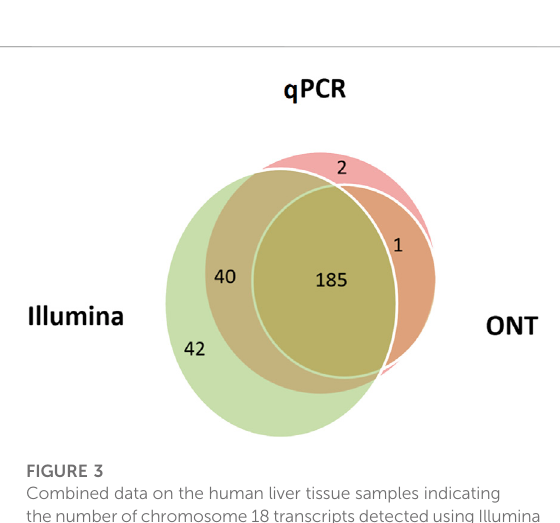
FIGURE 3 Combined data on the human liver tissue samples indicating thenumberofchromosome18transcripts detectedusingIllumina RNA-Seq data (FPKM > 0), qPCR (the number of cDNA copies per cell, S t ≤ 40), and ONT data (TPM > 0). A total of 270 transcripts out of 275 encoded on the selected chromosome were detected using all three